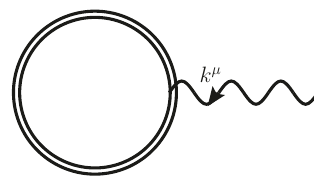
Figure 1 . The \tadpole" diagram formally vanishes by momentum conservation (in vacuum it vanishes by Furry’s theorem) but can contribute when sewn to a larger diagram. The double line indicates the particle propagator dressed to all orders by the background